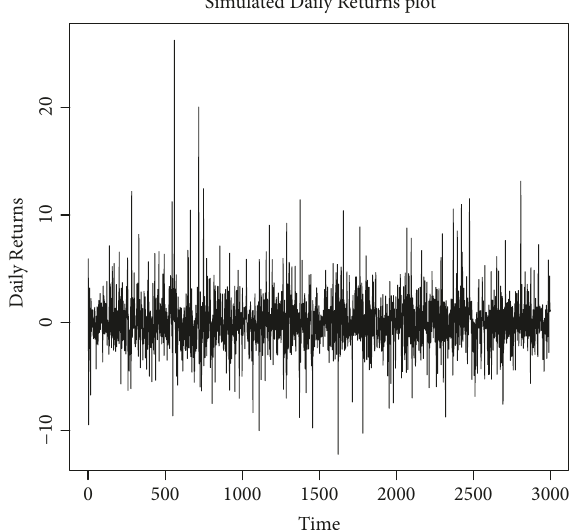
Figure1:Plotofthesimulateddailyreturnsshowingtheirevolution.